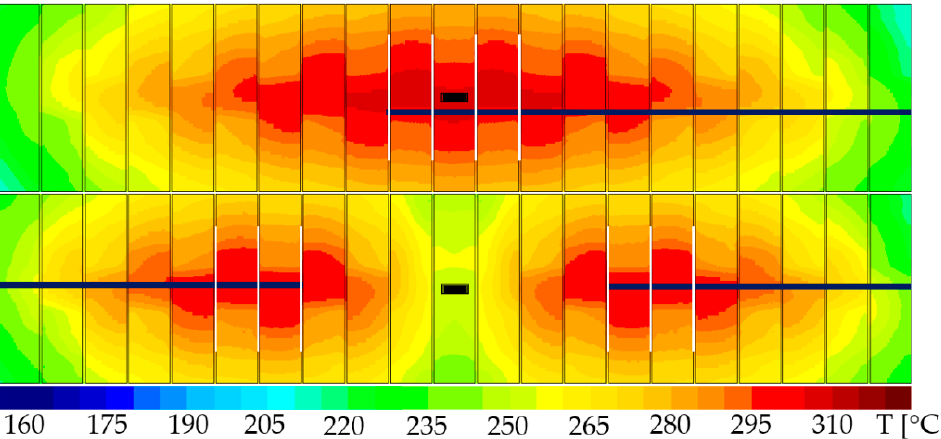
Figure 5. IMD cracking sensor grouping with regards to temperature distribution in TTML top—100%AA, bottom—90%AA.